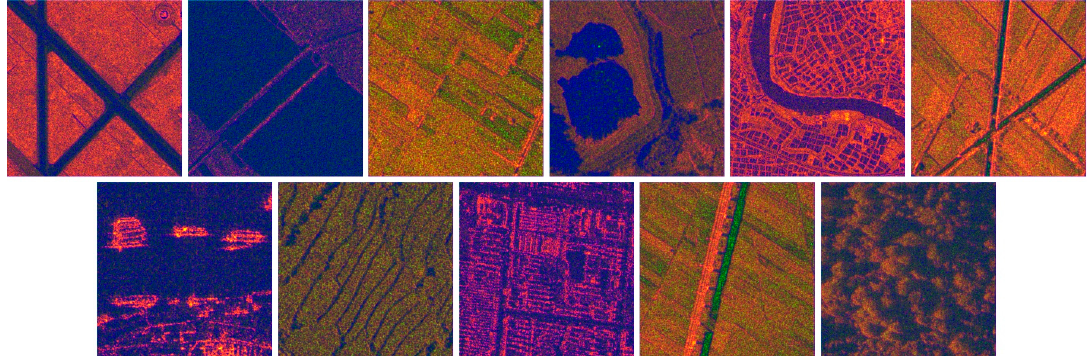
Figure 6. Fusion map of correlation and inertia for the 11 types of scenes.